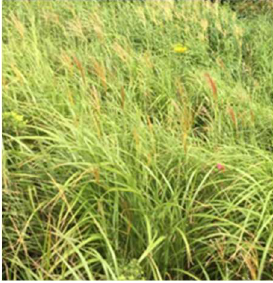
Figure 1. Miscanthus